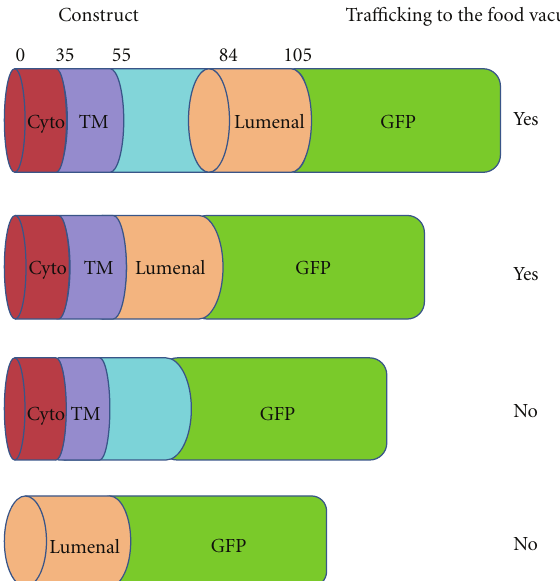
Figure 3: Schematic representation of the profalcipain-2-GFP constructs and their localization. Cytoplasmic (Cyto), transmembrane (TM), and lumenal portions of the prodomain are labeled. Green fluorescent protein is fused to study the tra ffi cking of